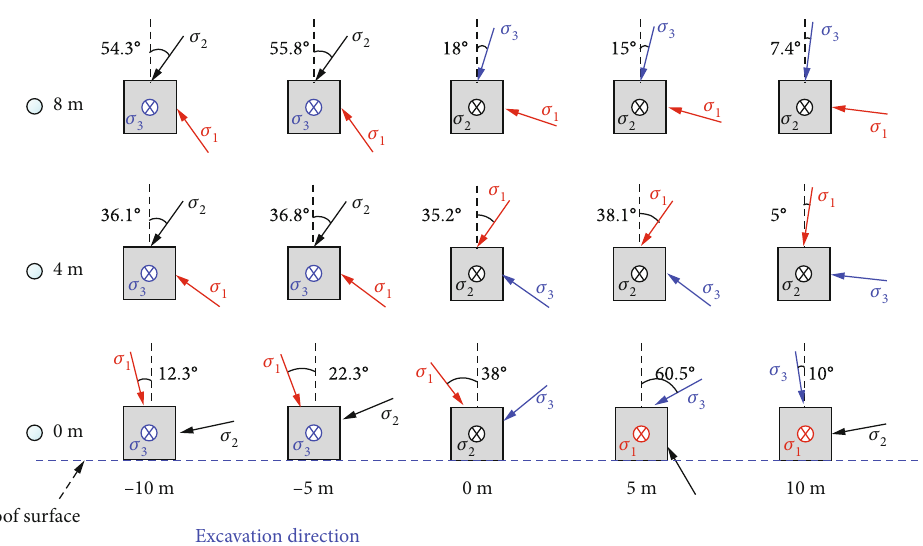
Figure 5: Variation of principal stresses.